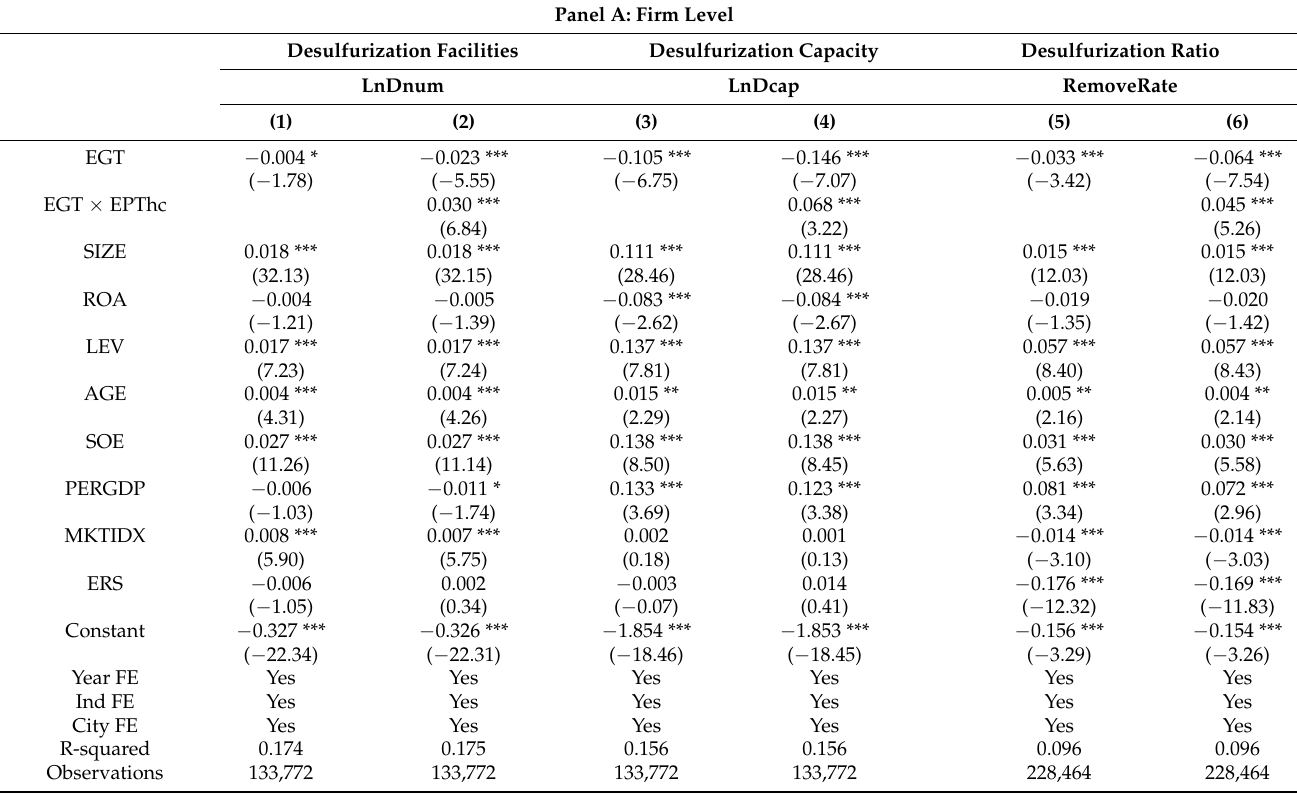
Table 8. Underlying mechanism: environmental regulation. Panel A: Firm